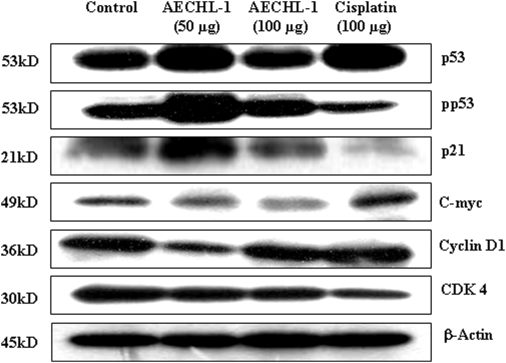
Effect of AECHL-1 on cell cycle regulatory proteins.Tumor tissue lysates were subjected to SDS-PAGE followed by Western
immunoblotting. Membranes were probed with anti-p53, pp53, p21, c-myc,
cyclin D1, cdk4, and β-actin antibodies followed by
peroxidase-conjugated appropriate secondary antibodies, and visualized
by enhanced chemiluminescence detection system. The experiments were
repeated thrice with similar results and a representative blot is shown
for each protein.